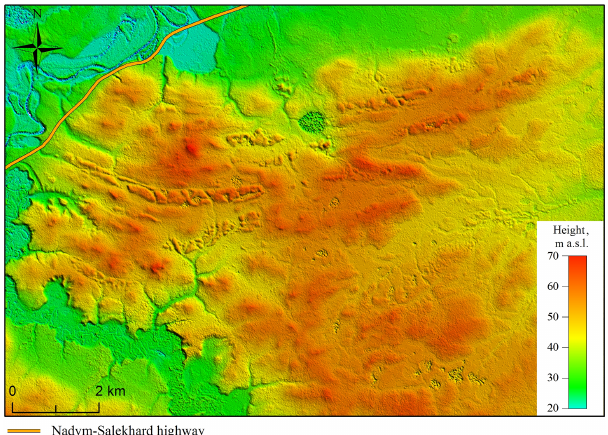
Figure 10. Parallel ridges, TanDEM-X DEM © DLR, 12m/px